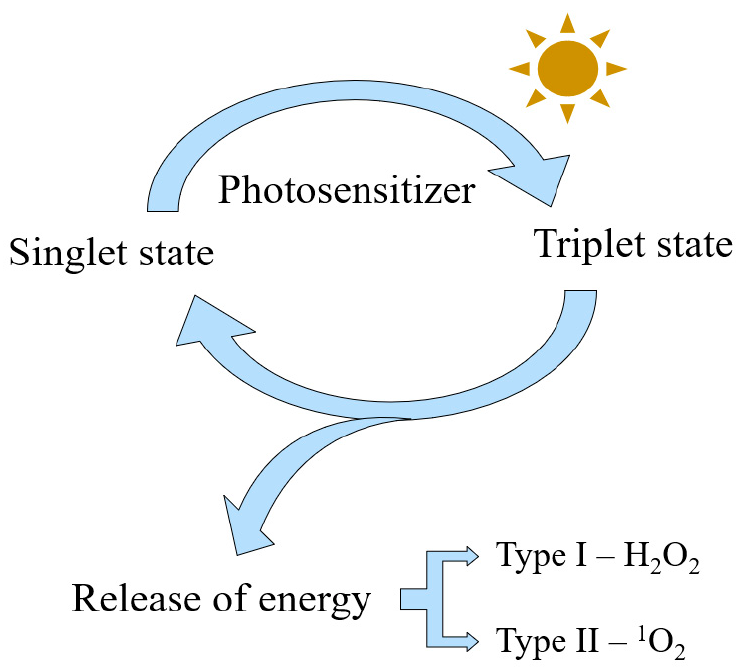
Figure 1. The mechanism of a photosensitizer action in photodynamic therapy.